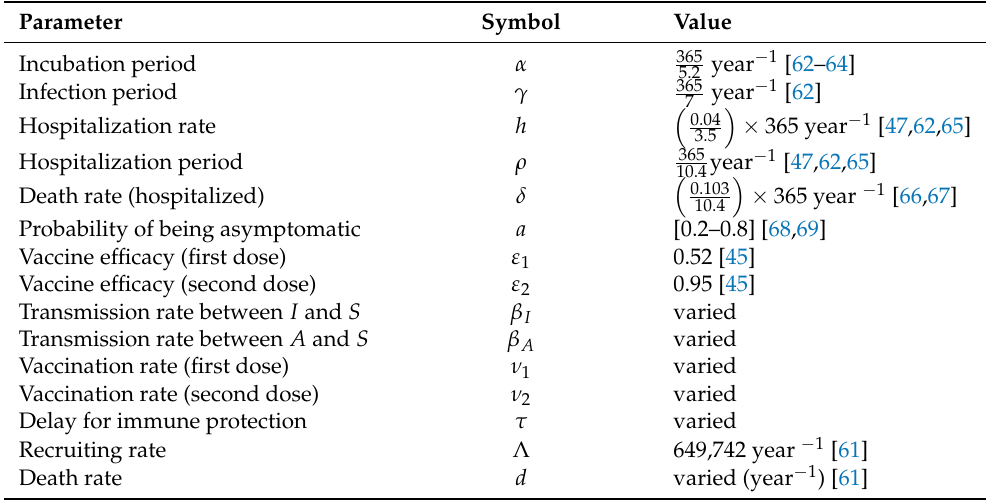
Table 1. Symbols and average values of the parameters used in the model of (1) to carry out numerical